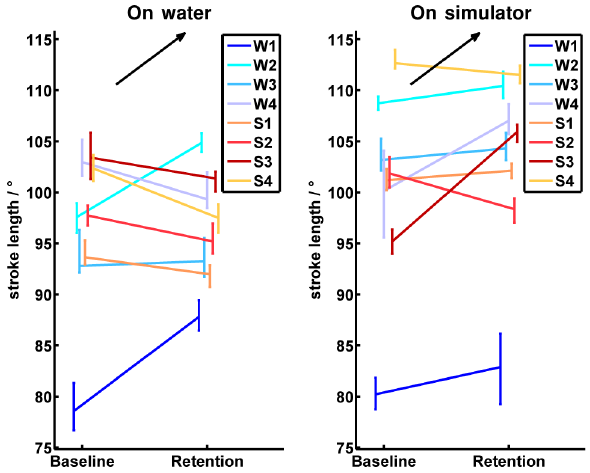
Figure 13. Absolute values of the stroke length. The left half image shows the development of all participants from baseline to retention tests on water, while the right half image illustrates the baseline and retention measurements on the simulator. Participants of the on-water group are indicated by bluish colors and abbreviated by W 1 to W 4 in the legend. Participants of the simulator group are indicated by reddish colors and abbreviated by S 1 to S 4 in the legend. The vertical bars in the baseline and retention tests cover all values performed by the corresponding participant. The measured values in the baseline and the retention tests are connected in the mean values for each participant. The black arrow indicates the direction of the desired development from baseline to retention in the corresponding test environment.